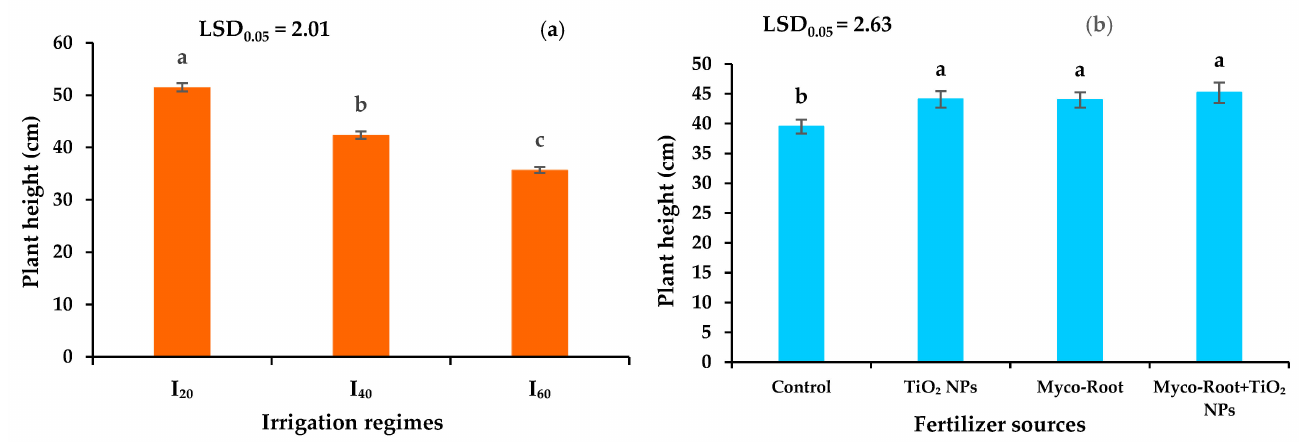
Figure 2. The effects of different irrigation regimes ( a ) and fertilizer sources ( b ) on the plant height of peppermint. I 20 , I 40 , and I 60 indicating well-watered, mild, and severe drought stress, respectively. Different letters indicate significant differences at the 5% level according to LSD’s test.